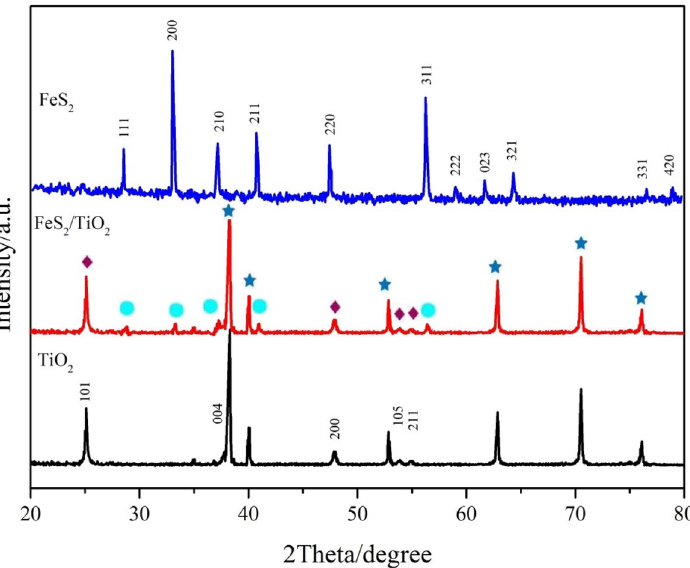
Figure 5. XRD patterns of pure TiO 2 , pure FeS 2 and FeS 2 /TiO 2 nanocomposites, the rhombus represents anatase type of TiO2 and star represents rutile type of